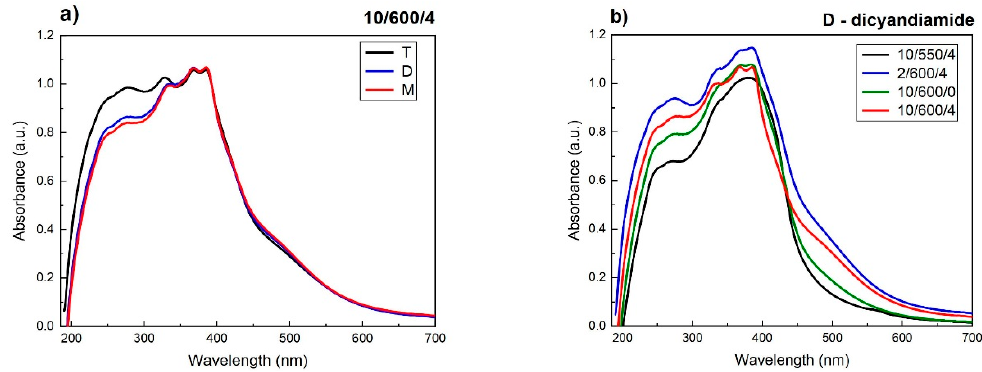
Figure 10. UV–vis spectra of carbon nitrides synthesized from various precursors ( a ) and under different condensation conditions from dicyandiamide ( b ).